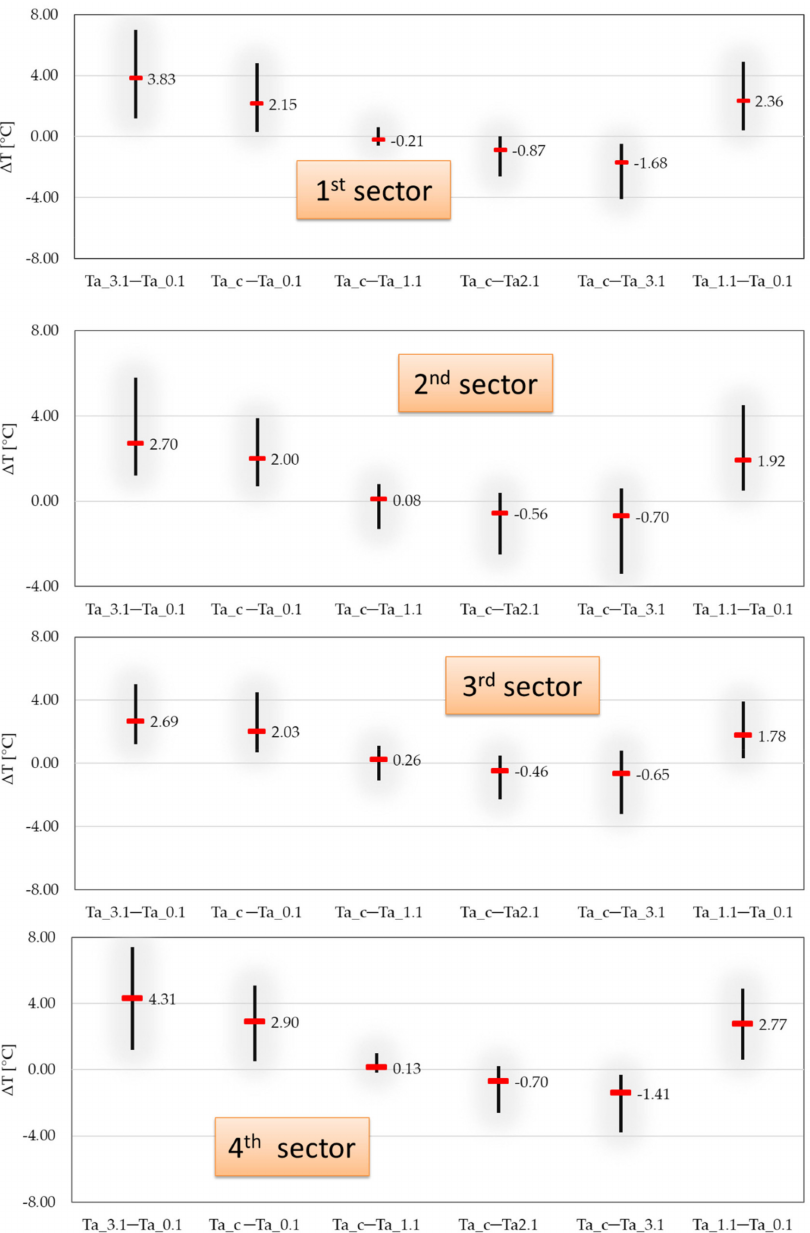
Figure 13. Extreme values for vertical temperature difference: